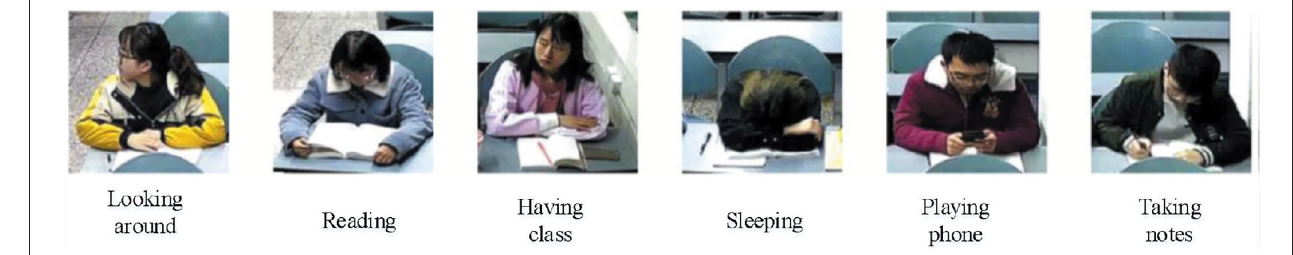
FIGURE 5 | Student behavior examples in